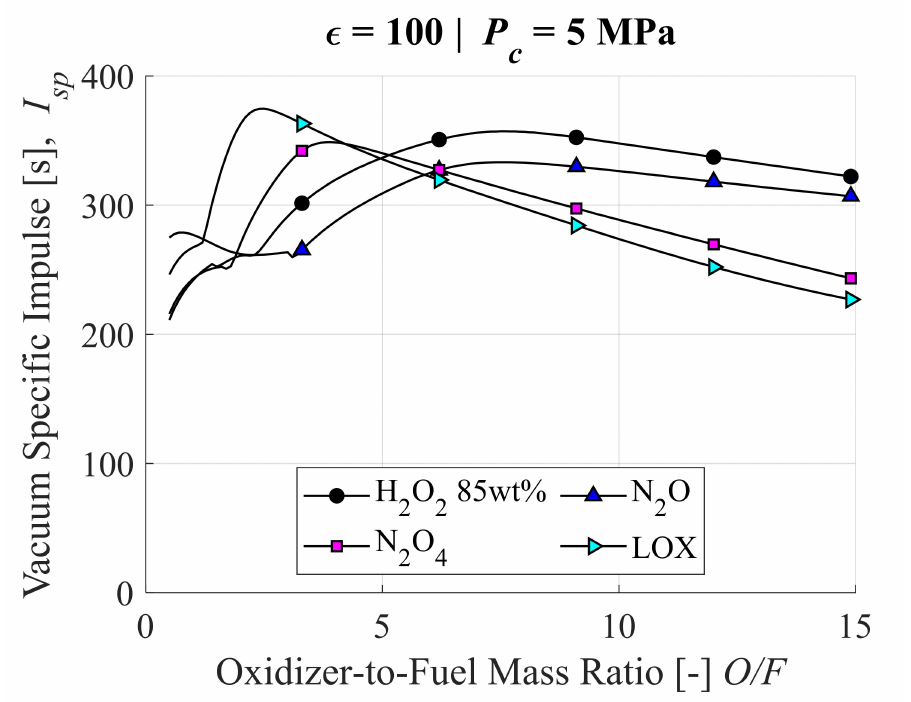
Figure 4. Comparison of theoretical I sp of the four oxidizers of this